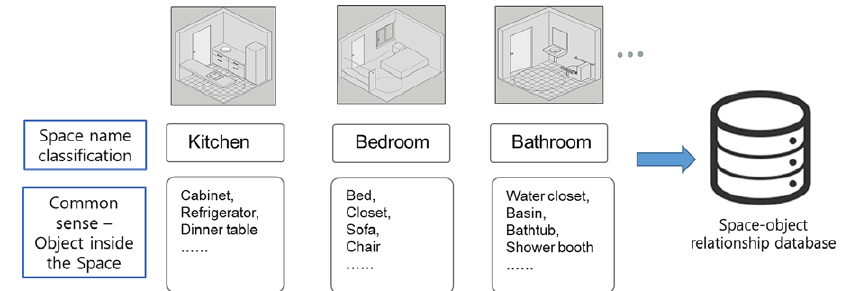
Figure 2. Composition of space–object relationship